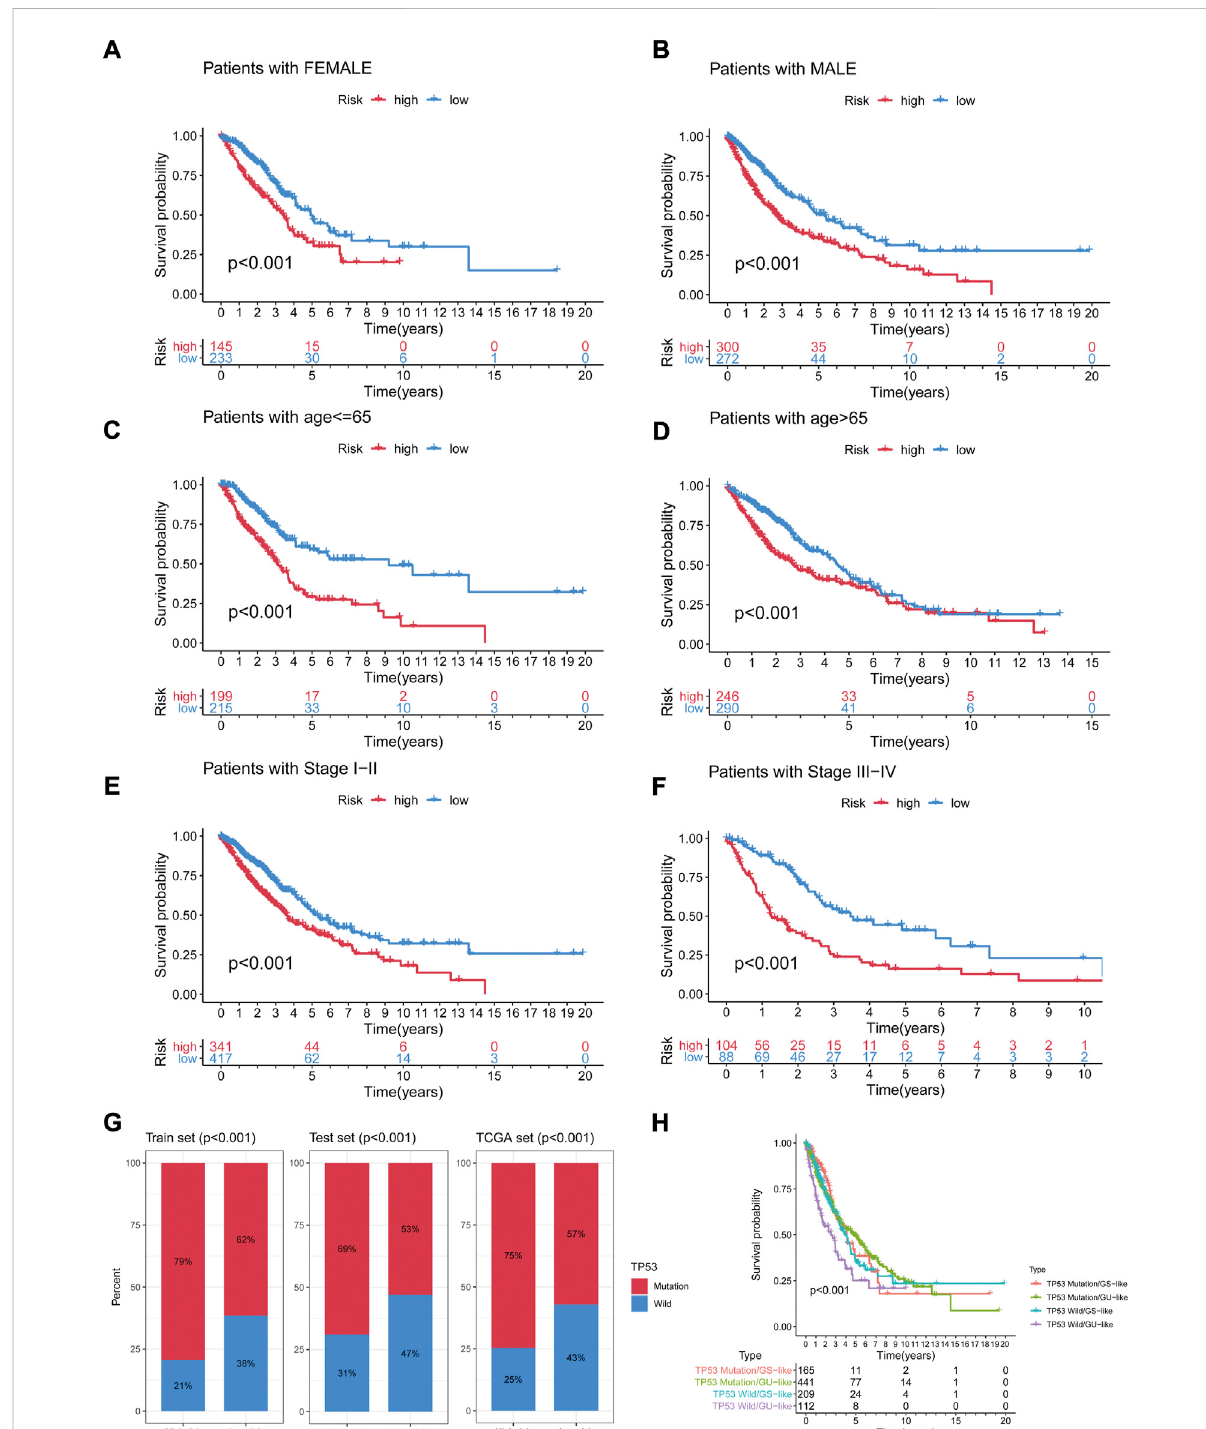
FIGURE 7 Strati fi cation analyses by age, gender and TNM stage and relationship between the GIrLncSig and TP53. Differences in OS between two groups in female (A) samples and male samples (B) ; in younger samples (C) and older samples (D) ; in early-stage samples (E) and late-stage samples (F) . (G) The percentage of TP53 mutation in the two risk groups in the three sets. (H) Kaplan-Meier curve analysis of OS for the four risk groups patients. GIrLncRNAs, genomic instability-related lncRNAs signature; OS, overall